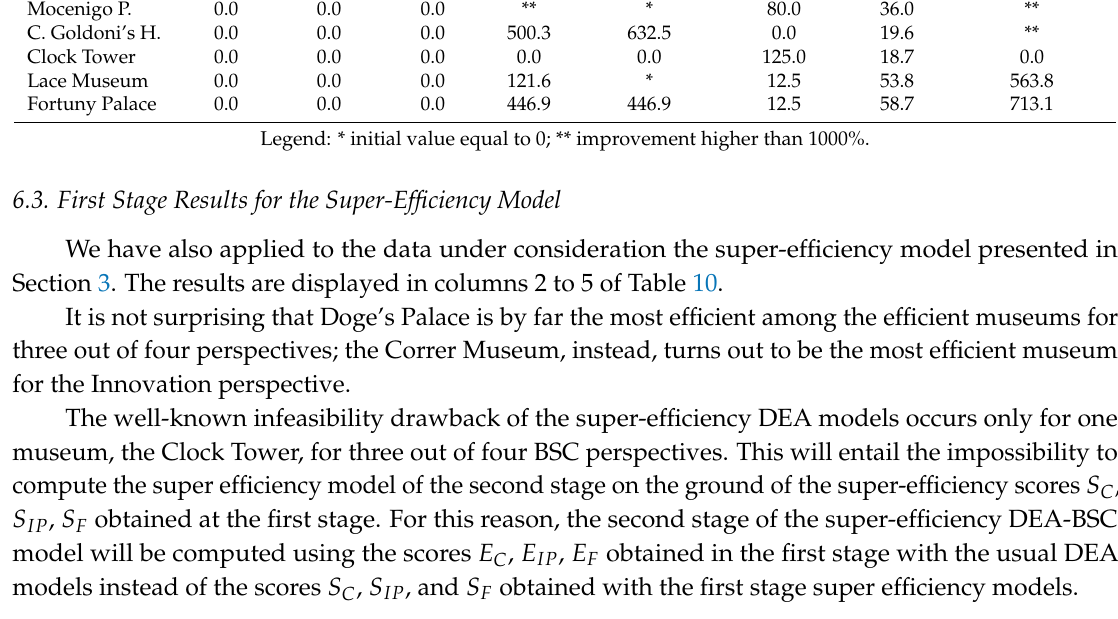
Table 10. Results of the super-efficiency DEA-BSC model for both the first and second stages. First Stage Second Stage Customer Museums